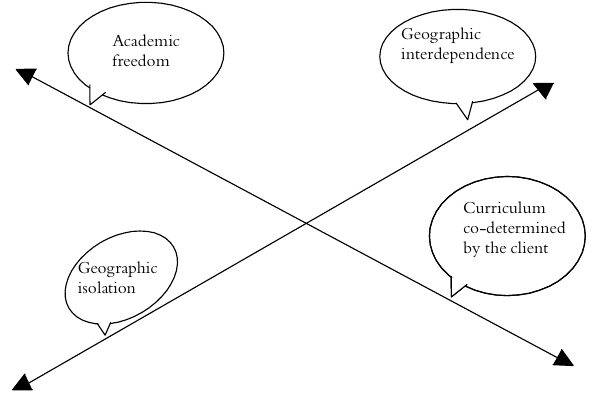
Figure 2: Twojuxtaposedcontinua ^ thedegrees of freedom and engagement